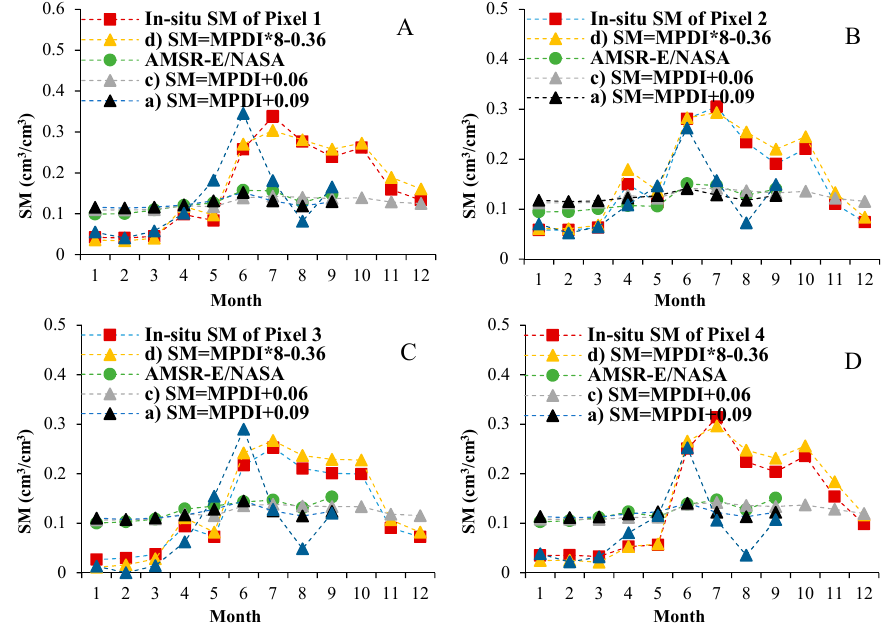
Figure 8. Monthly in-situ SM measurements and AMSR-E/NASA SM for the four cases in Table 1; Pixel 1 through Pixel 4 (A: Pixel 1; B: Pixel 2; C: Pixel 3; D: Pixel 4) in the Naqu area in 2011.